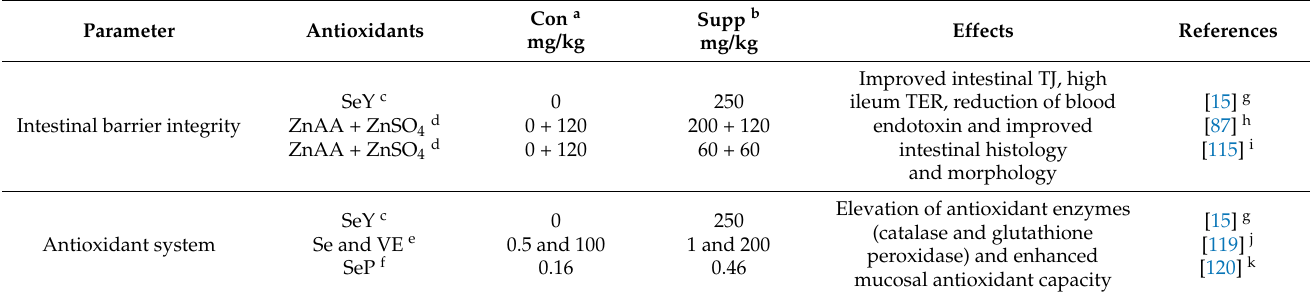
Table 3. Effects of antioxidants on the intestinal integrity and function of pigs under heat